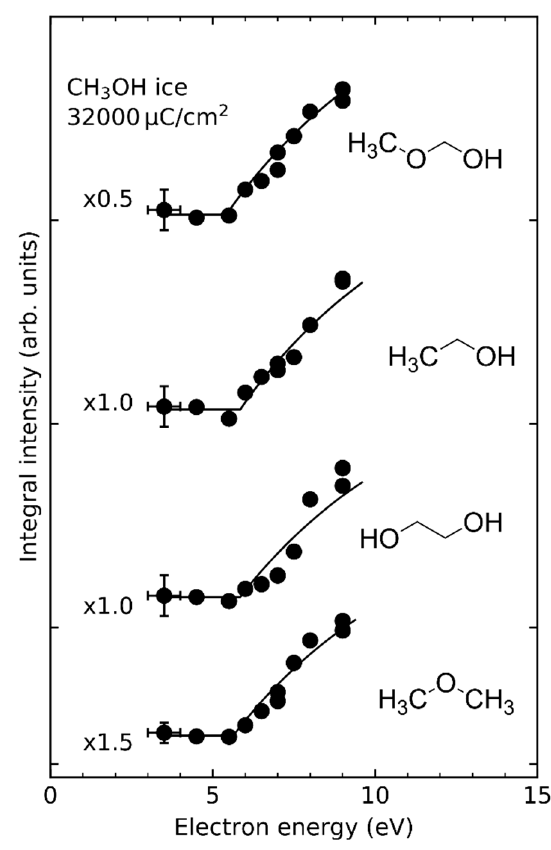
Figure 6. Dependence of the integrated desorption signals of methoxymethanol, ethanol, ethylene glycol, and dimethyl ether on electron energy obtained by TDS after irradiating pure CH 3 OH with 32 000 µ C/cm 2 in the range from 3.5–9 eV. The solid lines serve as a guide to the eye. Adapted with permission from Ref. [31]. Copyright 2021 American Chemical Society.